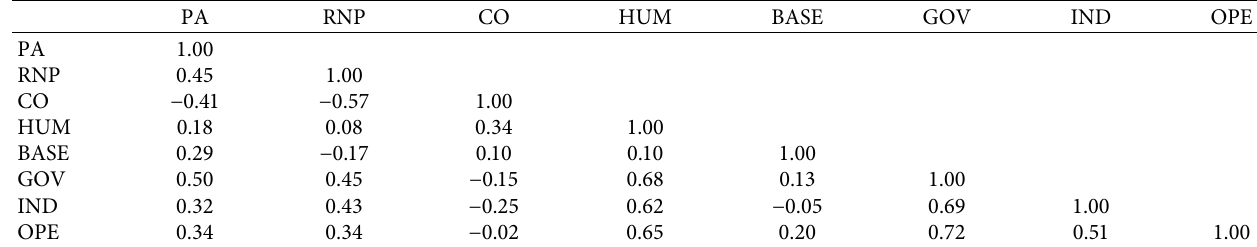
Table 4: Correlation coefficients between